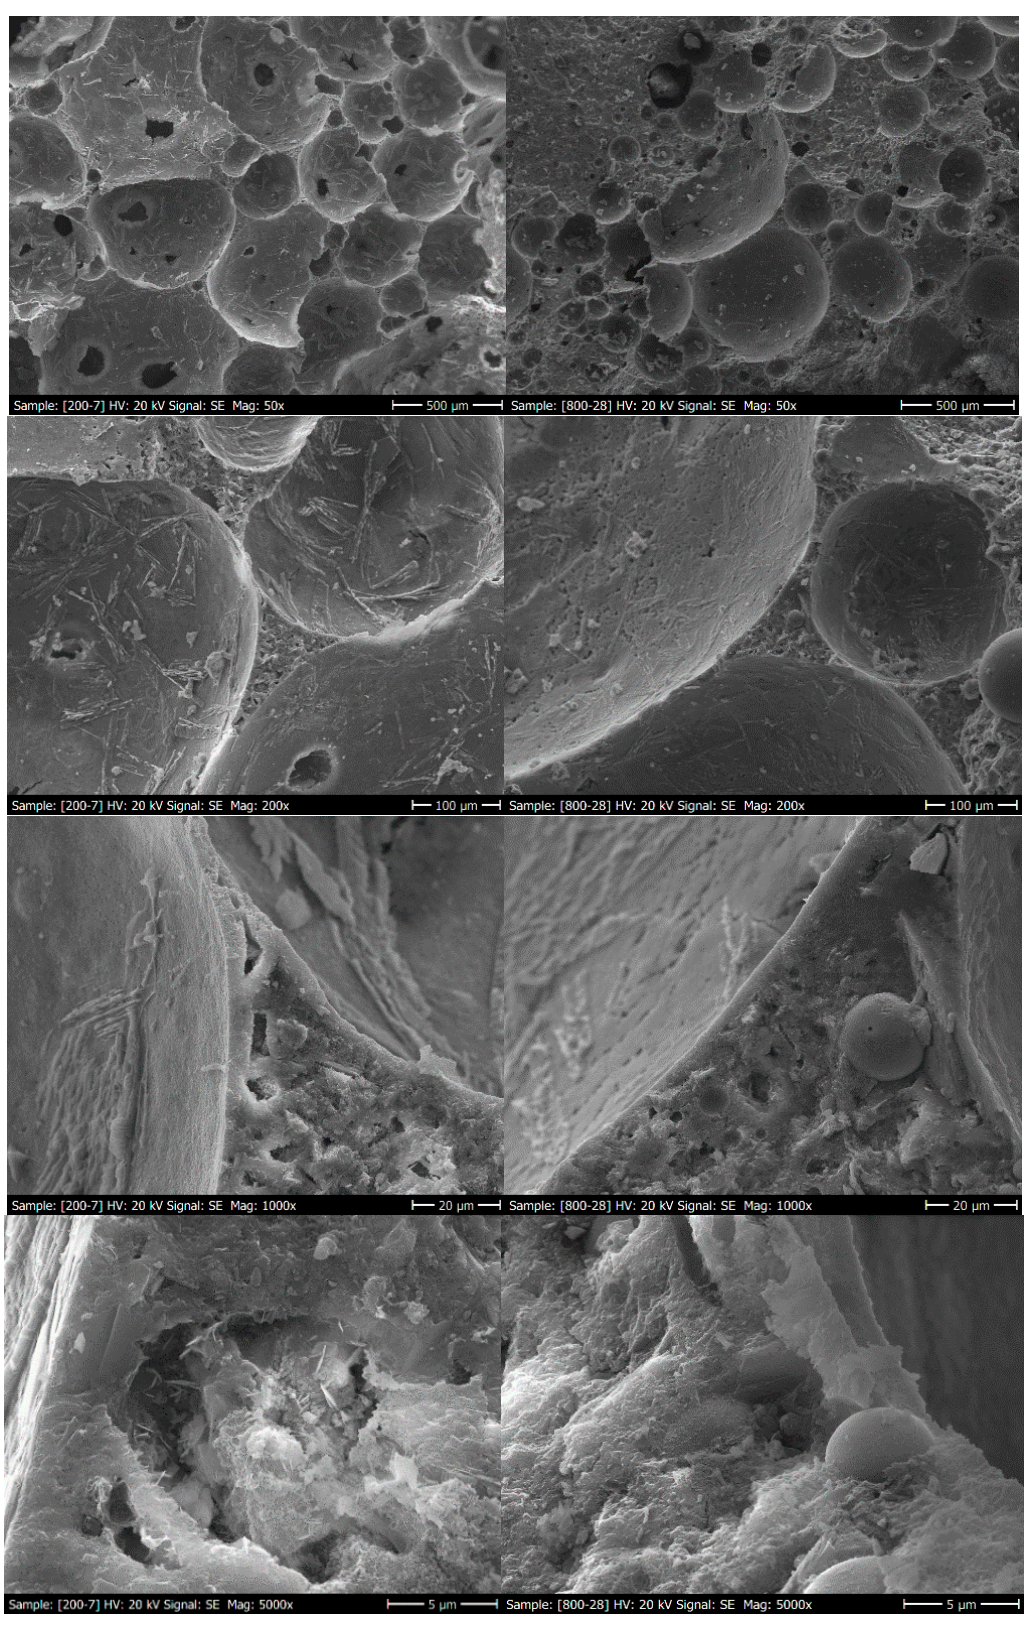
Figure 7. Scanning electron microscopy (SEM) images of foamed concrete mixes: control mix, C ( left ) and fly ash mix, C/FA ( right ).